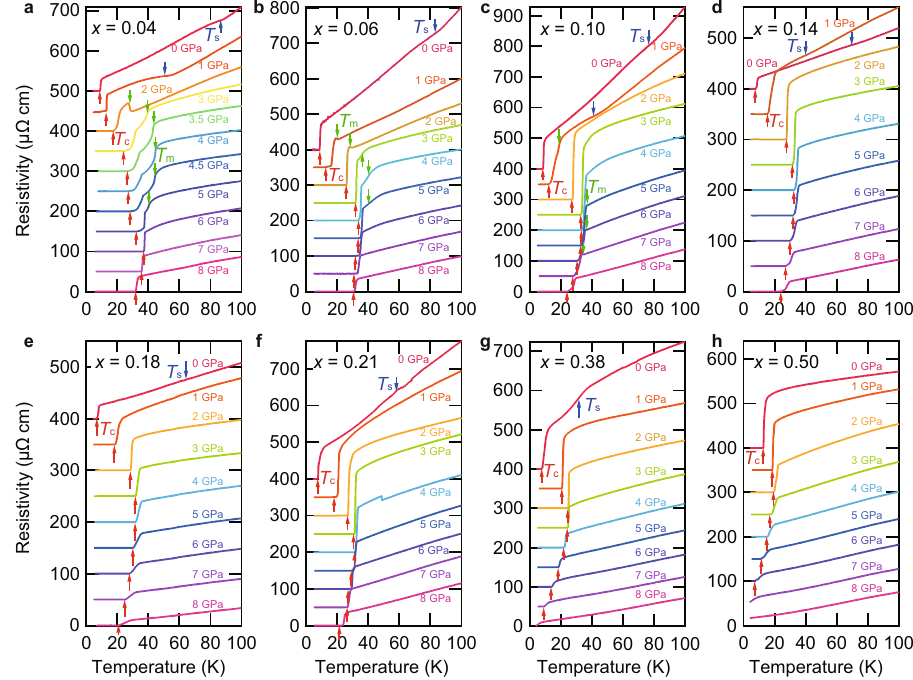
Fig. 3 Evolution of the temperature dependence of resistivity with pressure. Temperature dependence of resistivity in FeSe 1 − x Te x below 100 K at different pressures up to 8 GPa for x (Te) ≈ 0.04 ( a ), 0.06 ( b ), 0.10 ( c ), 0.14 ( d ), 0.18 ( e ), 0.21 ( f ), 0.38 ( g ), and 0.50 ( h ). The data are vertically shifted for clarity. The resistive anomalies at transition temperatures T s (blue), T m (green), and T c (red) are indicated by